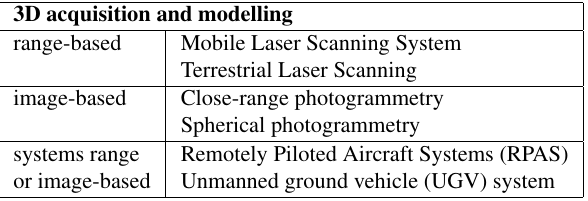
Table 2: 3D acquisition